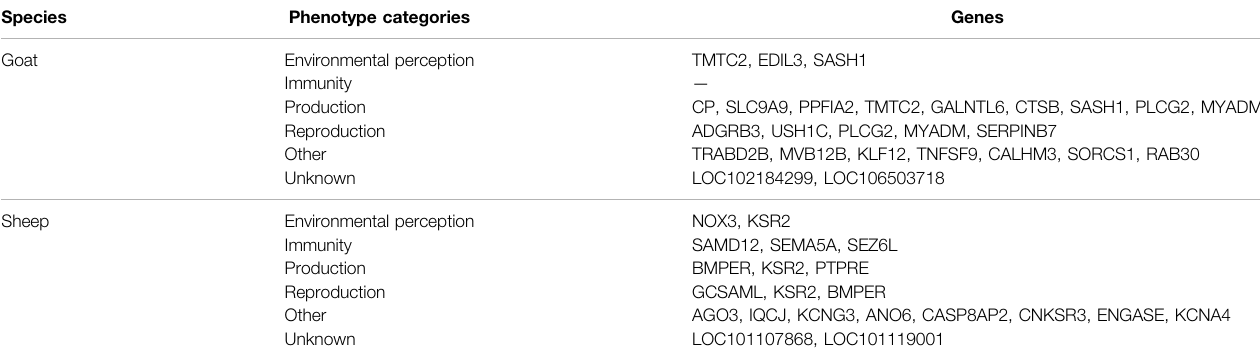
TABLE 1 | Phenotype categories in which the candidate genes (top 0.001%) are involved.